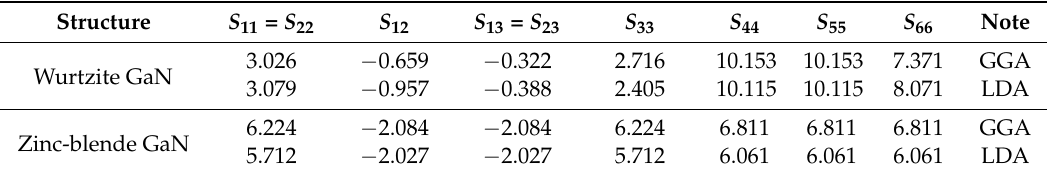
Table 3. Calculated elastic constant S ij , × 10 − 3